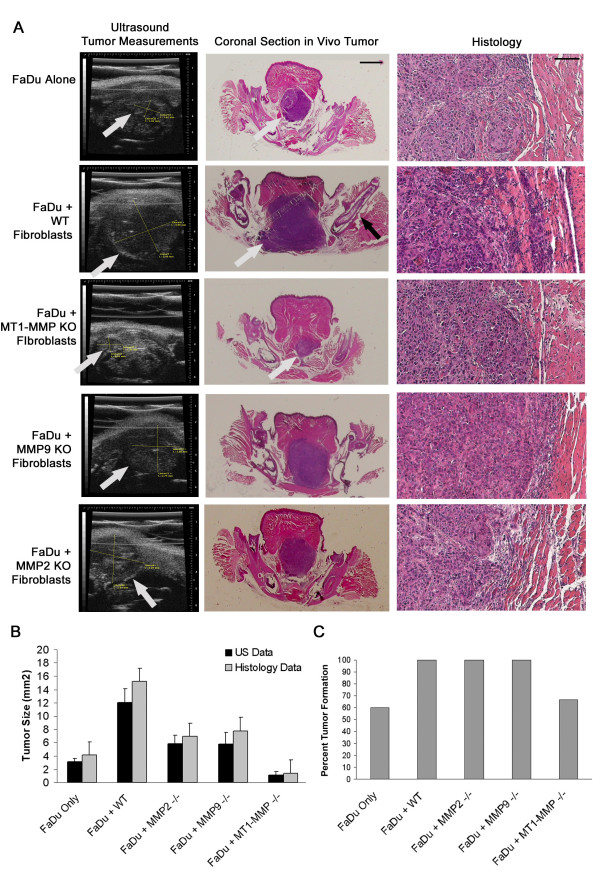
In vivo growth of FaDu cells co-injected with murine fibroblasts. FaDu tumor cells (4 × 105 cells) were injected transcervically into the oral cavity of SCID mice alone or in combination with WT fibroblasts (8 × 105), MMP-2 null, MMP-9 null or MT1-MMP fibroblasts (8 × 105 (data not shown) or 1.2 × 106 cells). Measurements of tumor growth were taken at 10 days by ultrasound examination and at 14 days by histological sectioning of the mandible-tongue complex in the coronal plane (bar is 1 mm in coronal sections or 100 μM in histology) (A). Greatest cross sectional tumor area measurements were compared (B) for both groups. C, percent tumor formation in the orthotopic SCID mouse model over the two week observation period was equal to the number of tumors formed divided by number of mice (one injection per mouse with least 10 mice were injected per group).